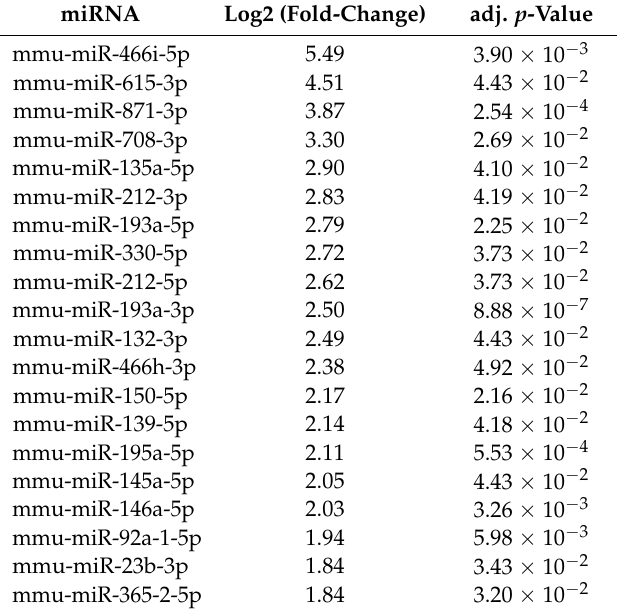
Table 1. Top 20 up-regulated miRNAs in Sonic Hedgehog Medulloblastoma Cancer Stem Cells (SHH MB CSCs) vs. Neural Stem Cells (NSCs). The entire dataset is reported in Table S1; adj., adjusted.